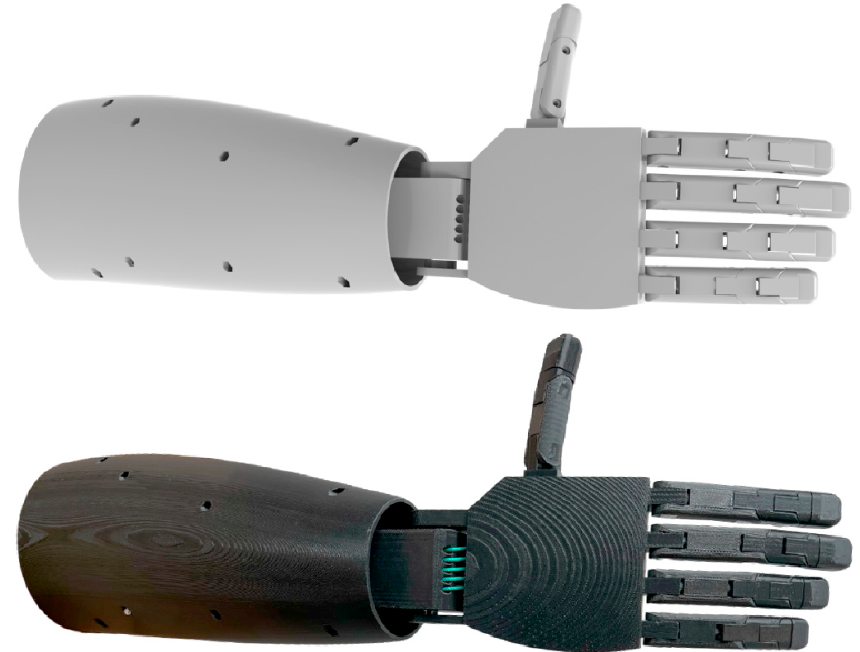
Figure 4. Prosthesis control servo motors.